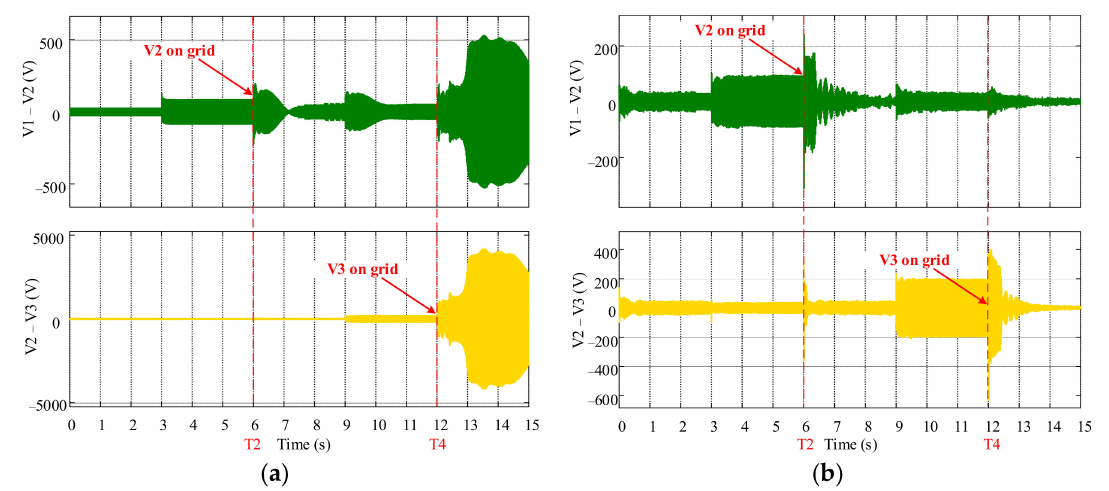
Figure 10. The voltage differences when they were connected with the traction grid with a load: ( a ) the traditional control strategy; ( b ) the proposed strategy.